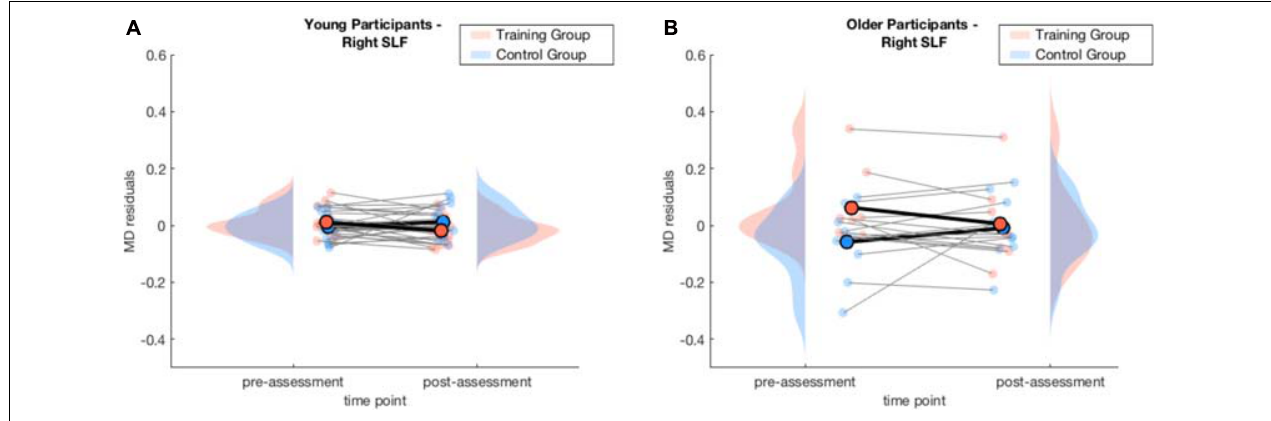
FIGURE 6 | Averaged MD residuals accounting for CNR, in-scanner head motion, and global MD for the right SLF of the WM group and AC group at pre-assessment and post-assessment of the generalized linear mixed-effects model for each age group separately. (A) comparison of young WM group and young AC group. (B) comparison of older WM group and older AC